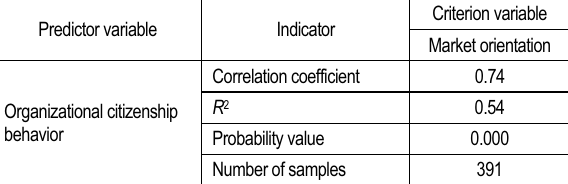
Table 4. The relationship between